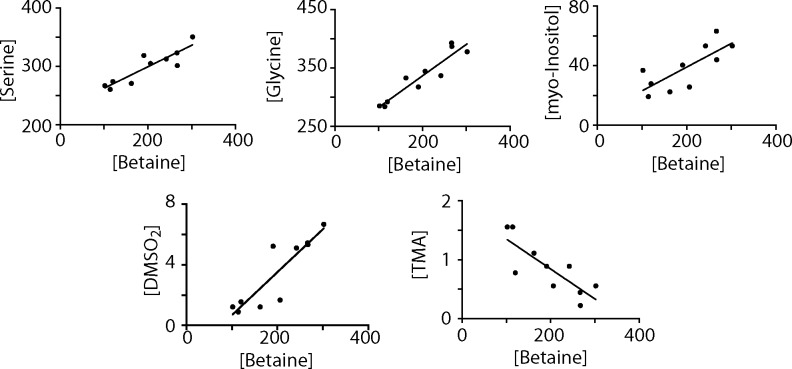
Correlation analyses of metabolites involved in betaine metabolism.